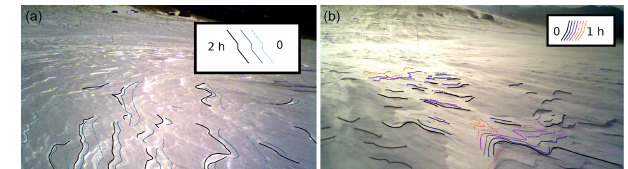
Figure 7. The movement of snow steps on Niwot Ridge, Colorado, (a) 21 March 2016 12:06–14:06 (video S1 at 3:35, photo at end of observation) and (b) 13 March 2016 07:09–08:09 (video S1 at 3:57, photo at beginning of observation).